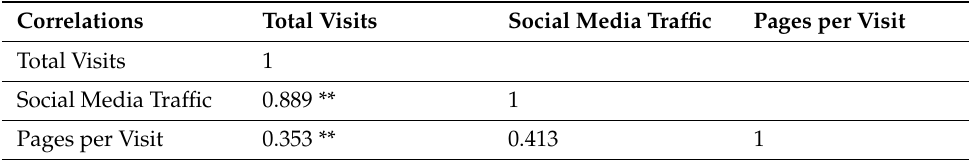
Table 6. Coefficients between the examined metrics for H3.